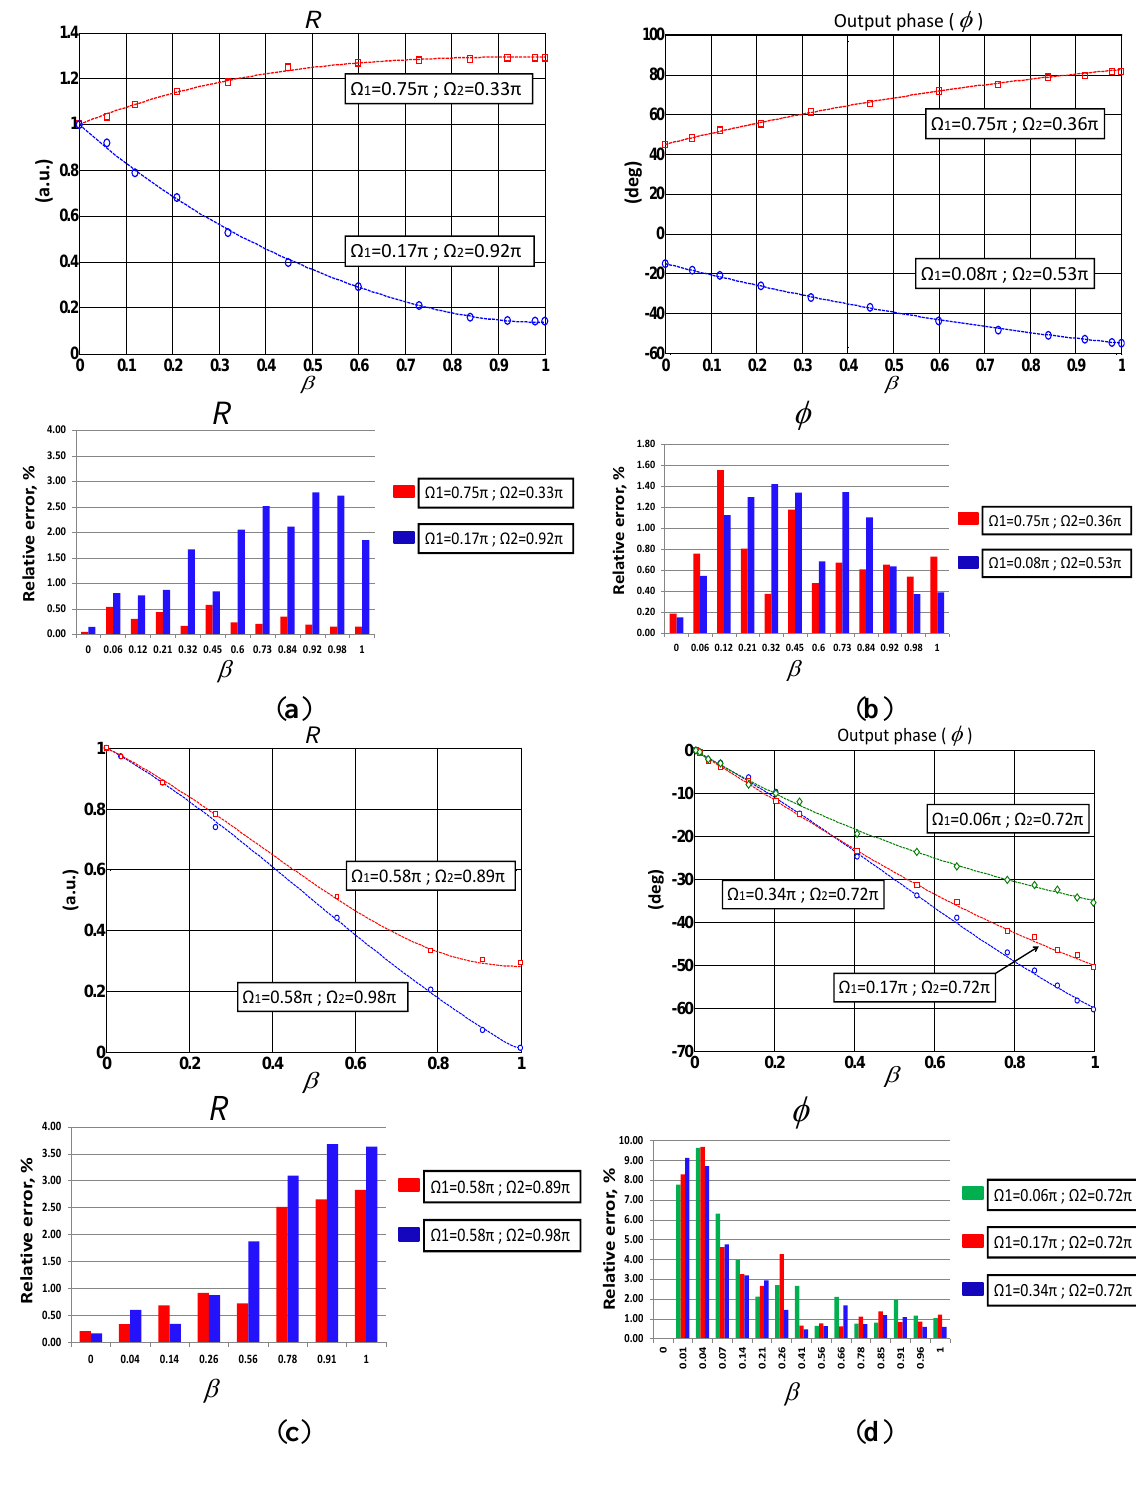
Figure 5. Experimental results and theoretical curves for both self-referencing parameters at different virtual phase-shifts, ( a ) and ( c ) R parameter; ( b ) and ( d ) Output phase Φ . Theoretical curves are drawn in solid lines. Figures inset: relative errors (in %) of the measurements